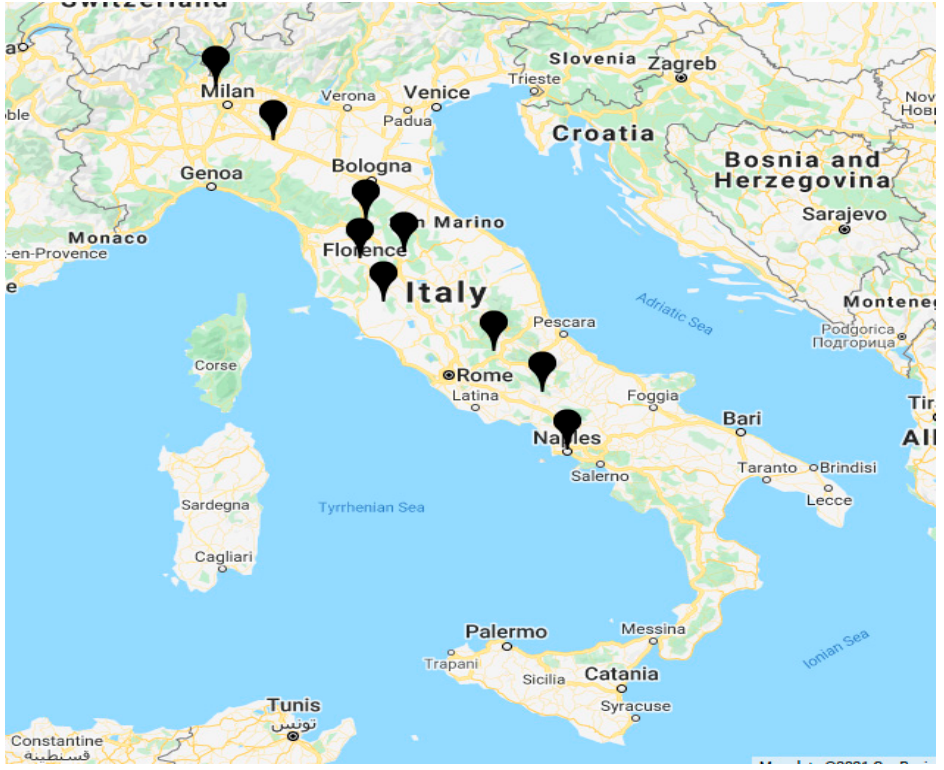
Figure 6. Map showing all nine different regions under study.